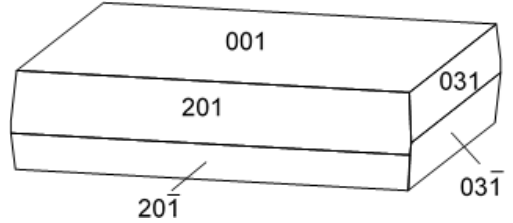
Figure 2. Clinographic projection of a gobelinite crystal from Cap Garonne, France. Drawn with FACES (Favreau,